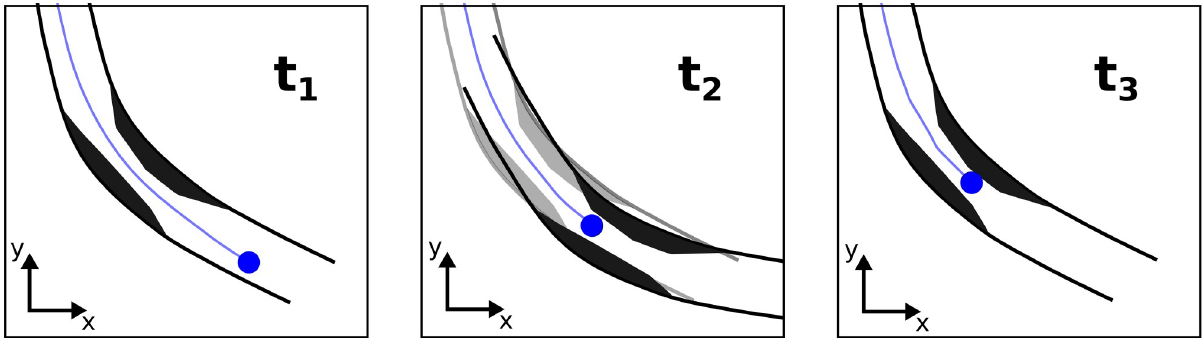
Fig 5. Exemplary sketch of heart beat motion artifact. Due to heart contraction the imaged artery is deformed for time stamp t 2 . Meanwhile, the catheter tip (blue dot) moves continuously backwards. After heart contraction ( t 3 ) the artery gets back to its original shape ( t 1 ). Again, the catheter motion is continued in between. This relative motion between catheter and artery leads to multiple IVOCT imaging of the sketched stenosis (black).